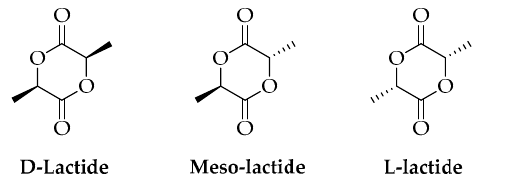
Figure 2. Stereoisomers of lactide.